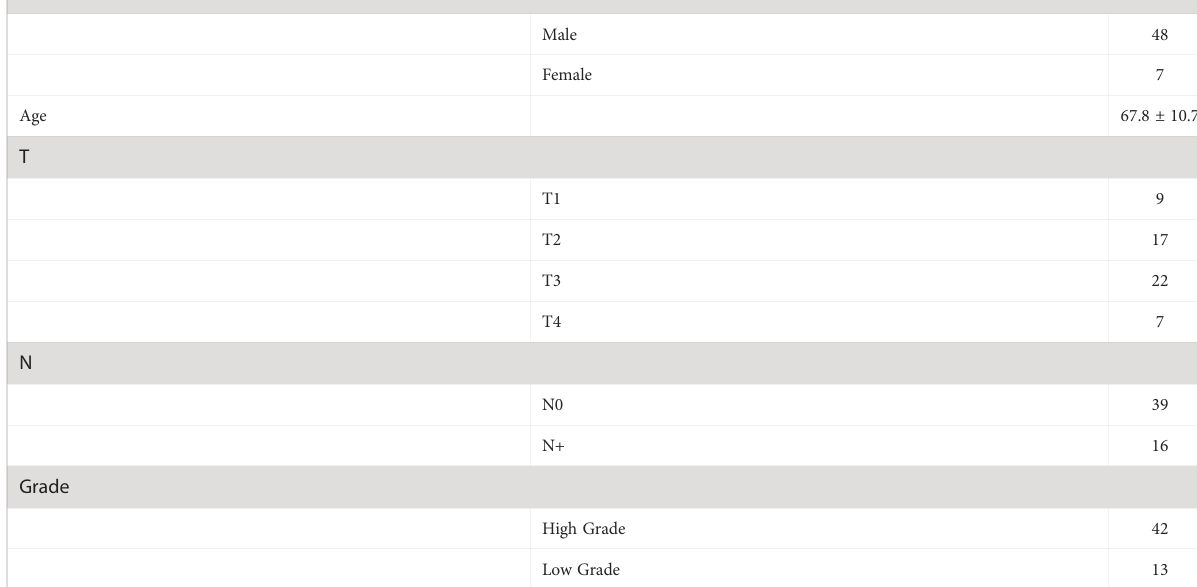
TABLE 1 Characteristic of patients. Characteristic of patients